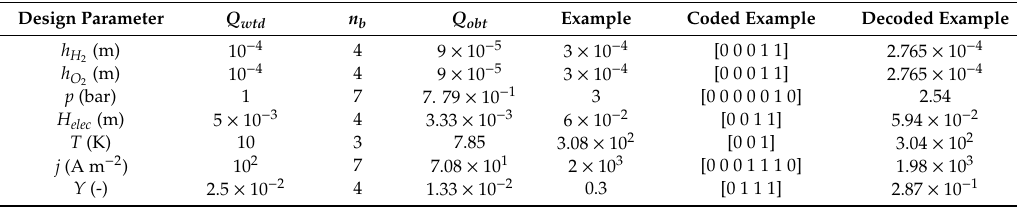
Table 5. Design parameter and their